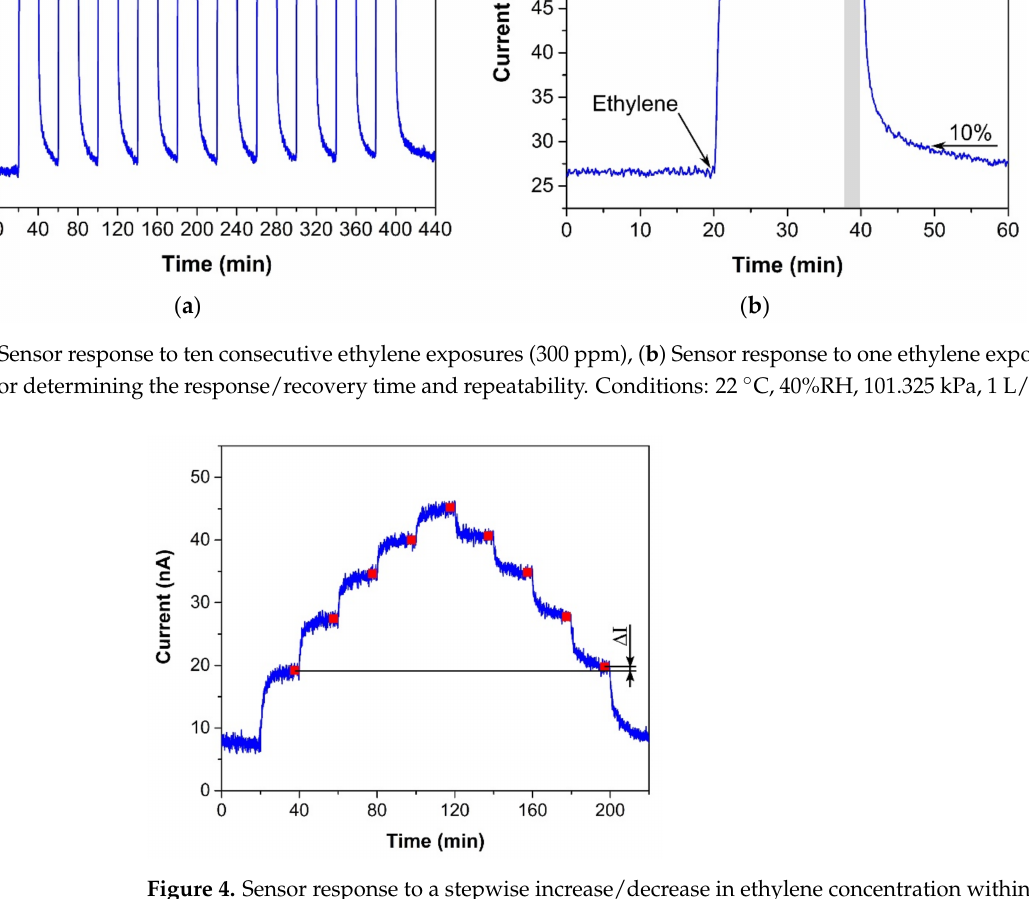
Figure 4. Sensor response to a stepwise increase/decrease in ethylene concentration within the range